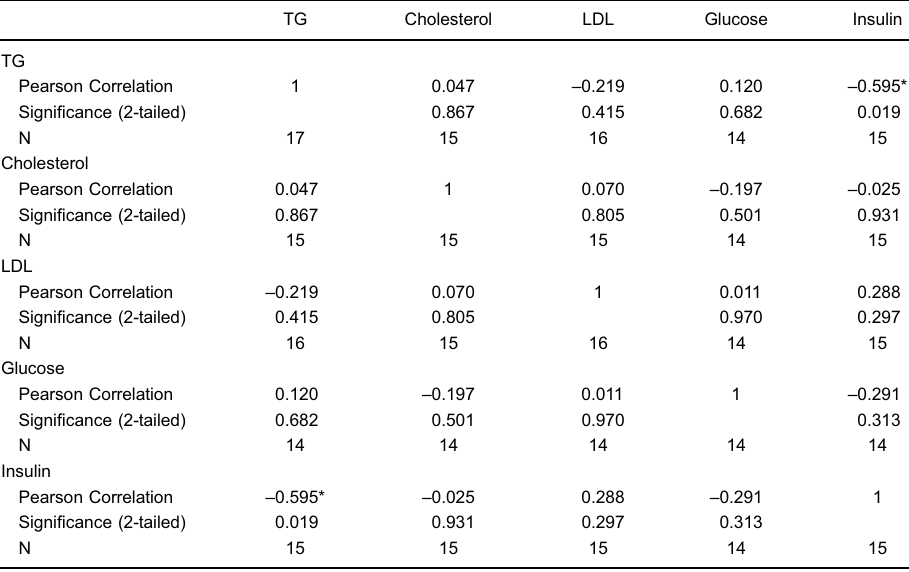
TG Cholesterol LDL Glucose